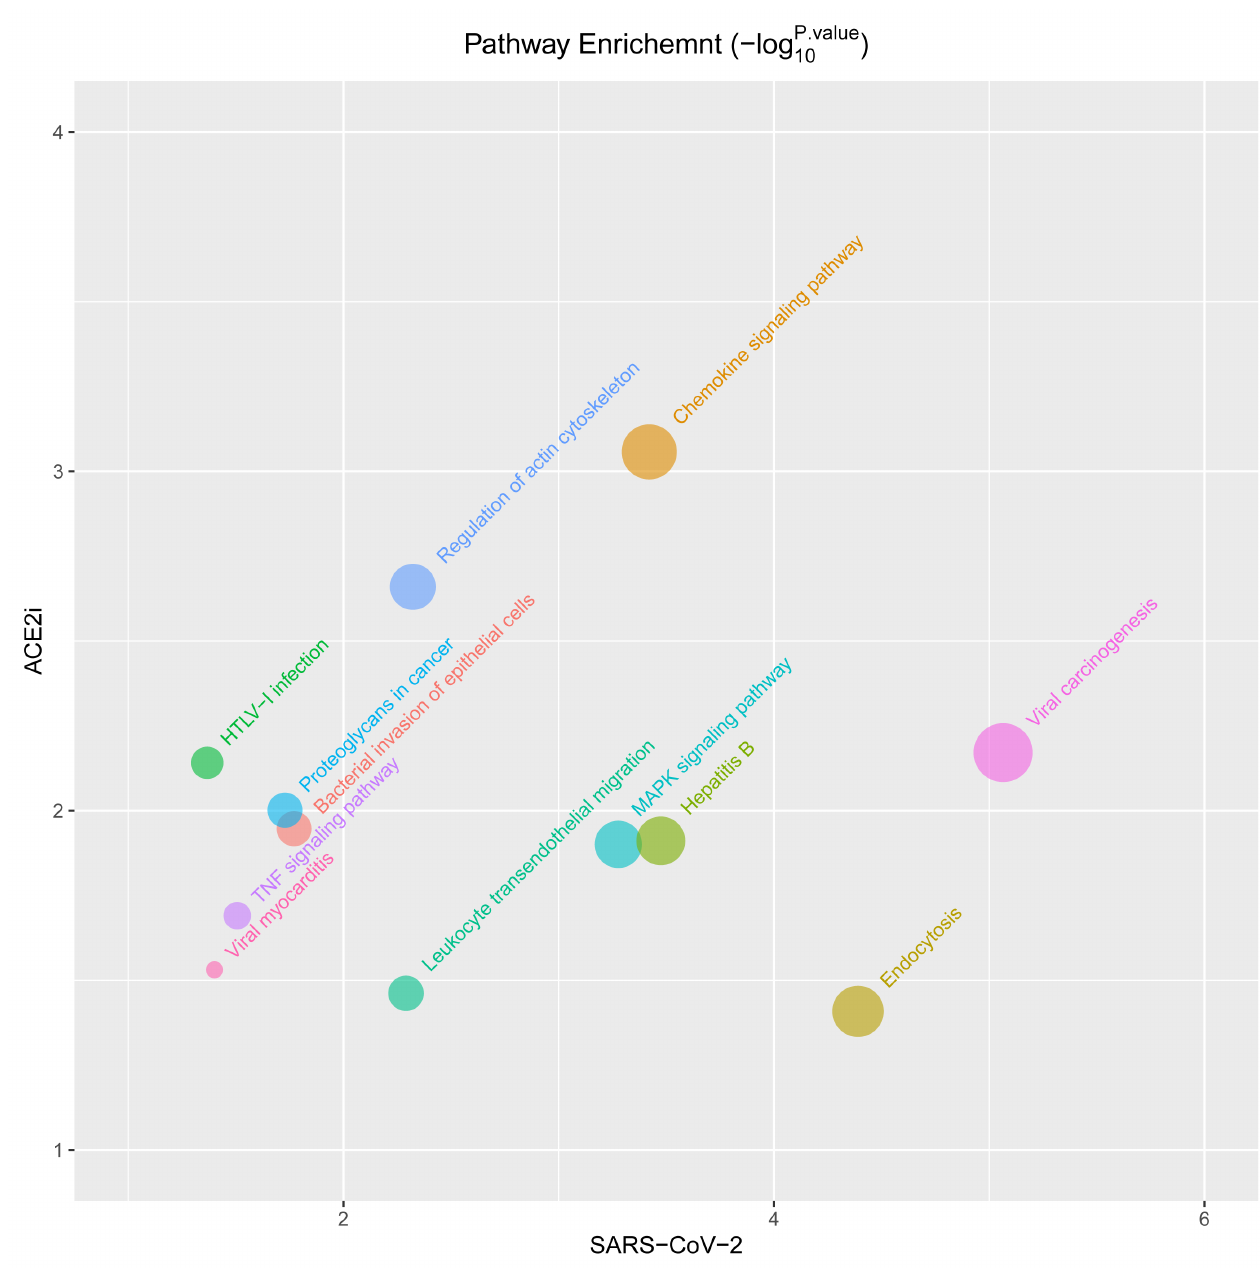
Figure 3. The bubble plot of significantly enriched pathways in HCC515 cells with ACE2 inhibitor inhibition and human COVID- 19 patient lung tissues. X-axis and Y-axis show -log10 transformed P-values in human COVID-19 patient lung tissues (SARS-CoV-2) and HCC515 cells with ACE2 inhibitor inhibition (ACE2i), respectively. Size of the bubble shows the average value of -log10 transformed P-value in SARS-CoV-2 and ACE2i.